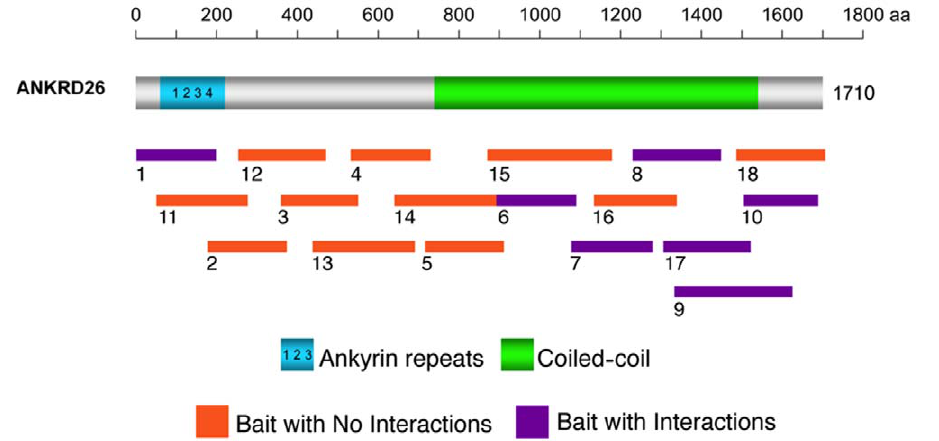
Figure 1. ANKRD26 yeast two-hybrid strategy. The position of ANKRD26’s ankyrin and spectrin coiled-coil repeats are depicted on a schematic diagram of the full-length, 1710 amino acid, protein. The line below indicates the relative locations of ANKRD26 bait clones used in the GAL4- based yeast two-hybrid cDNA library screens. DIPA interacts with baits 7, 8, 9 and 17; GPS2 interacts with bait 17; HMMR interacts with baits 9 and 17; and TRIO interacts with bait 10.